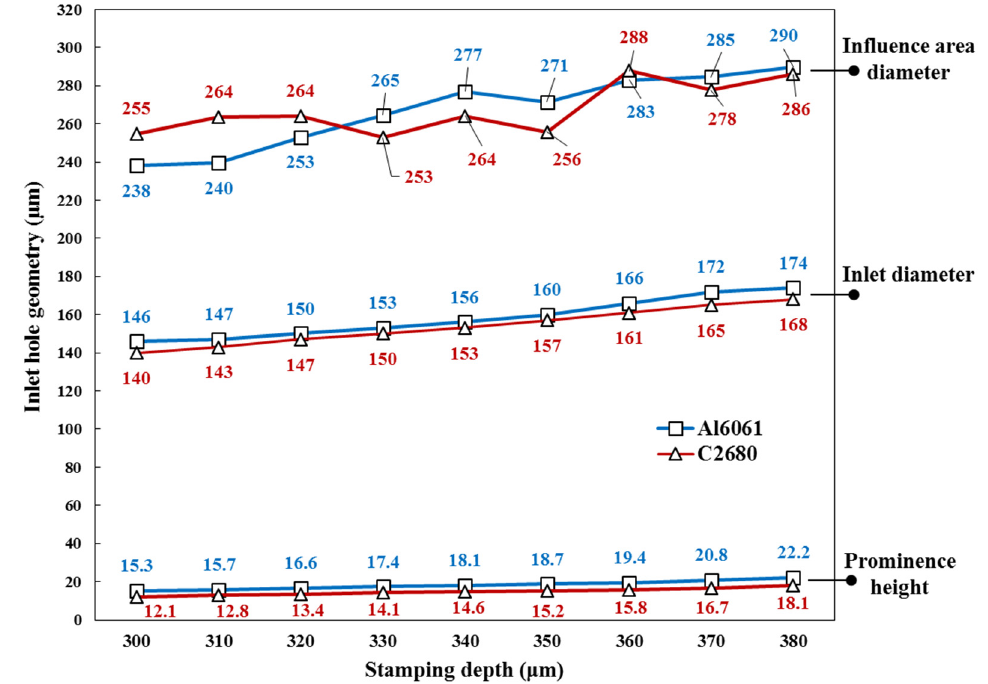
Figure 11. Stamping depth/inlet hole geometry analysis.